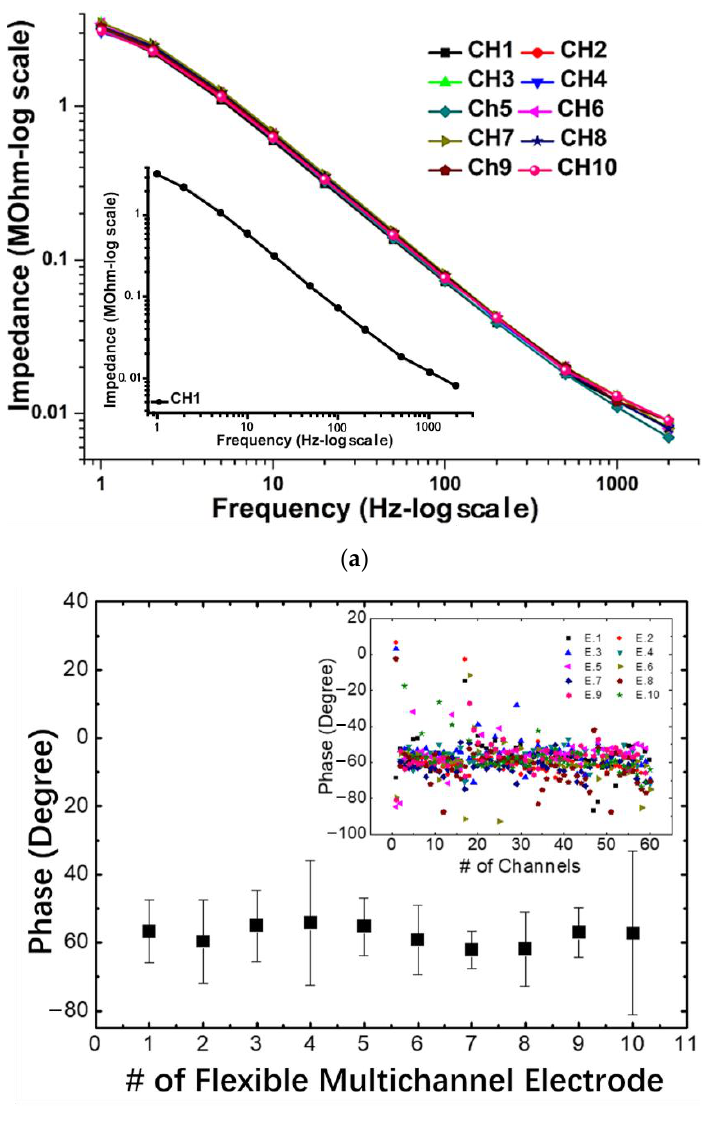
Figure 7. The measurement impedance and phase properties of MEAs: ( a ) the measured impedances of 10 random MEA channels, with the inset image of single random channels of MEAs, including the error bars; ( b ) the measured phase angles of the same 10 random MEAs at 1 kHz.